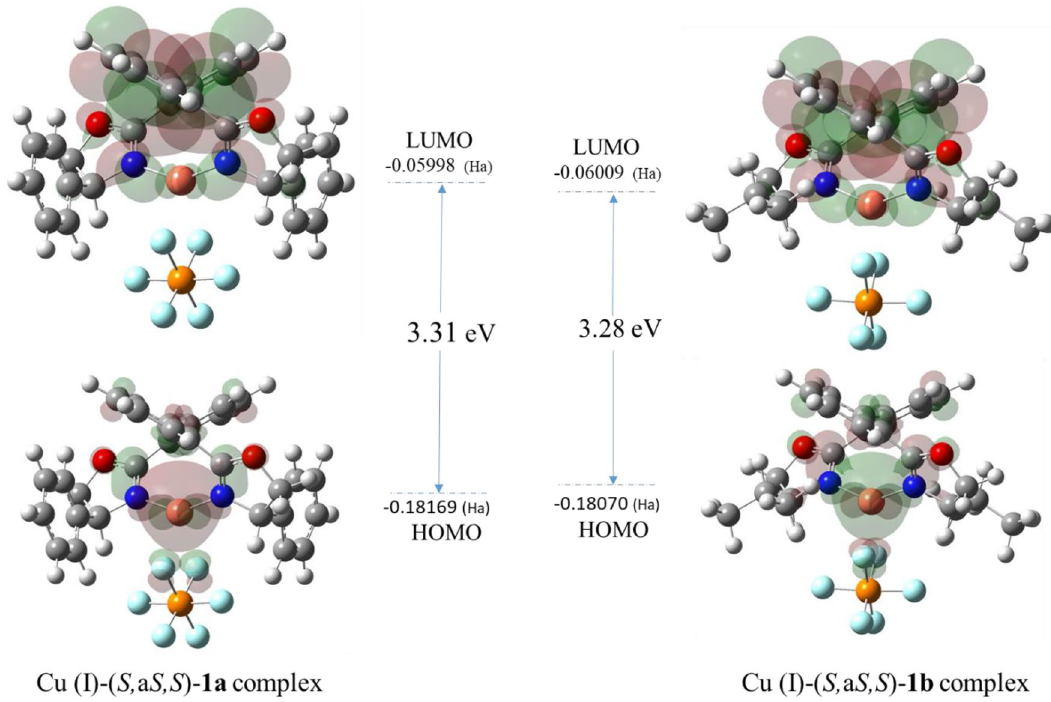
Figure 5. HOMO–LUMO energy gaps of the Cu (I) - ( S,aS,S )- 1a and Cu (I) - ( S,aS,S )- 1b complexes.